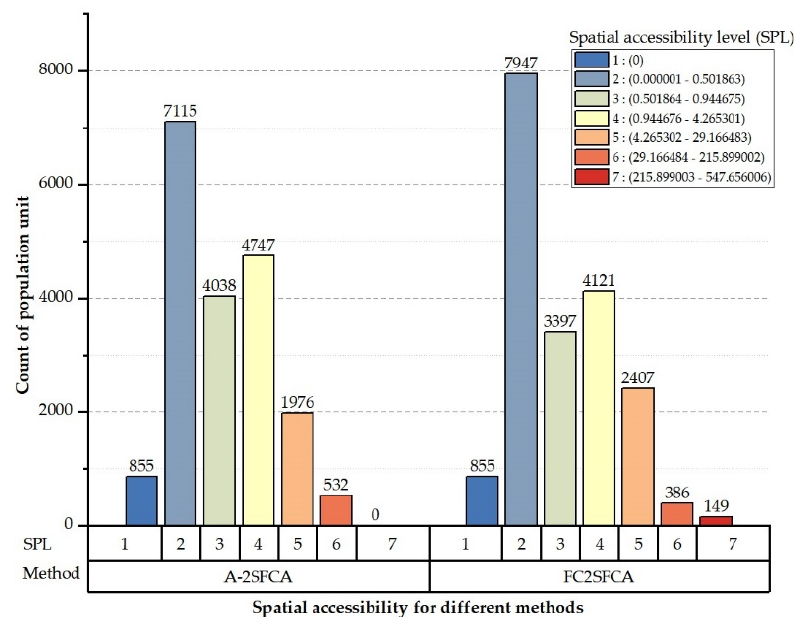
Figure 9. Comparation of s patial accessibility calculated by two methods.